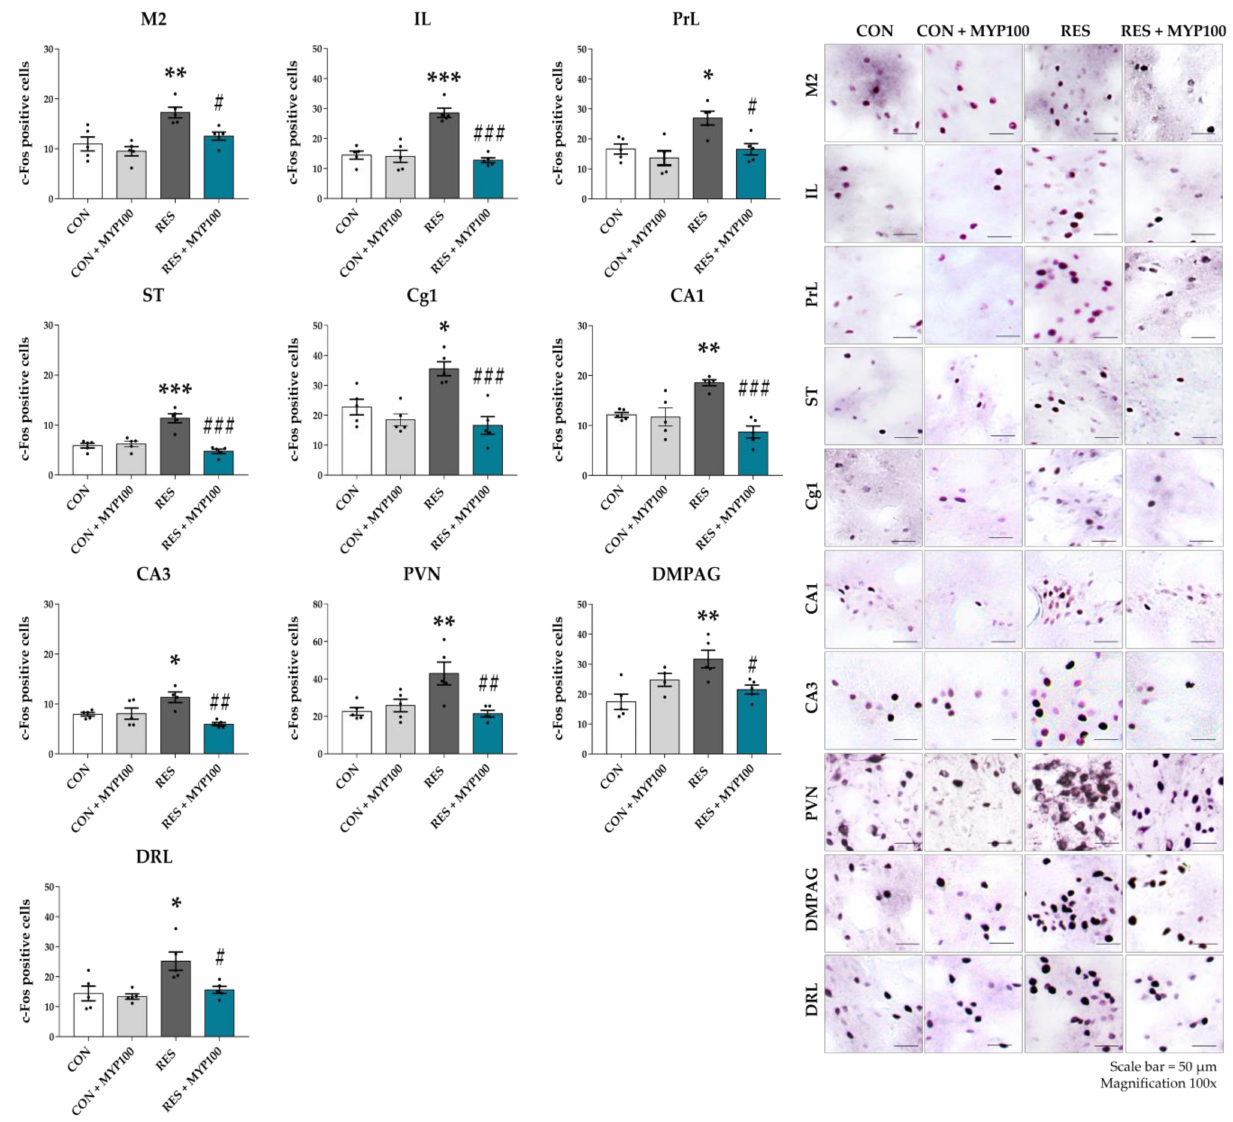
Figure 5. Alteration of c-Fos expression by myelophil (MYP) treatment in each brain regions. The number of c-Fos positive cells in the motor cortex area 2 (M2), infralimbic cortex (IL), prelimbic cortex (PrL), striatum (ST), cingulate area 1 (Cg1), cornu ammonis area (CA) 1 and CA3 of hippocampus, paraventricular nucleus (PVN), dorsomedial periaqueductal gray (DMPAG), and lateral part of the dorsal raphe nucleus (DRL) regions was significantly reduced by 100 mg/kg of MYP treatment. CON: control ( n = 5), CON + MYP100: 100 mg/kg MYP treatment ( n = 5), RES: 2 mg/kg of reserpine treatment ( n = 5), RES + MYP100: 2 mg/kg of reserpine followed by 100 mg/kg of MYP treatment ( n = 5). Data are expressed as means ± SEM. One-way ANOVA test with Tukey post hoc tests was executed. * p < 0.05, ** p < 0.01, *** p < 0.001 vs. CON; # p < 0.05, ## p < 0.01, ### p < 0.001 vs.